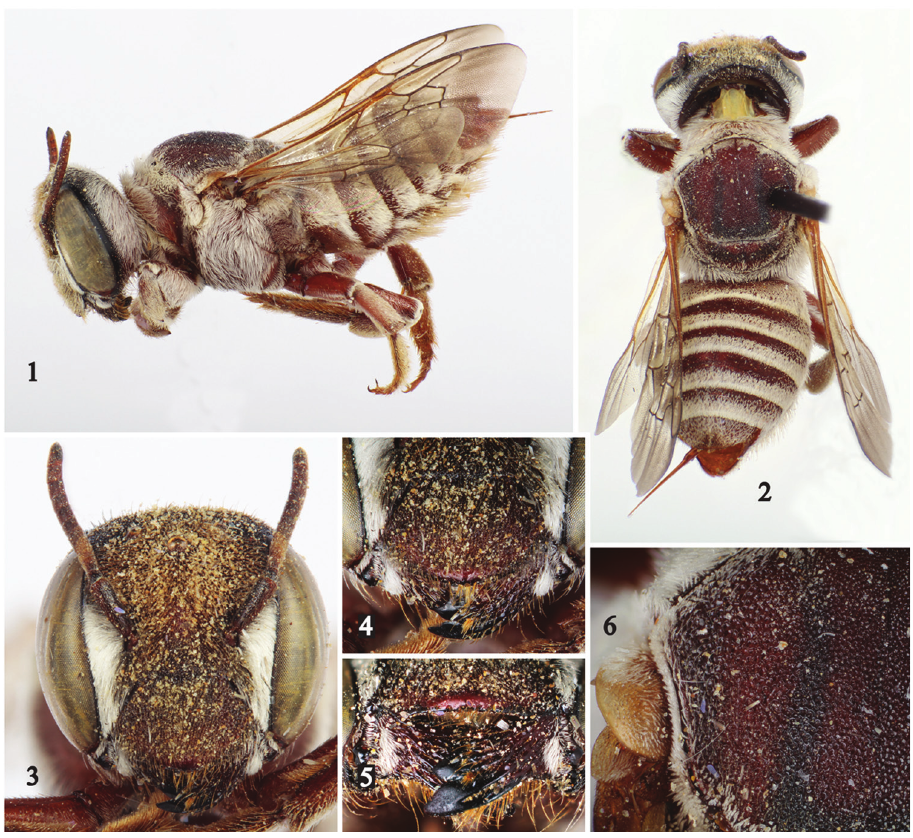
Figures 1–6. Photomicrographs of female holotype (KSMA) of Chalicodoma ( Pseudomegachile ) riyad- hense sp. n. 1 Lateral habitus 2 Dorsal habitus 3 Facial view 4 Detail of clypeus 5 Detail of mandibles 6 Detail of mesoscutal